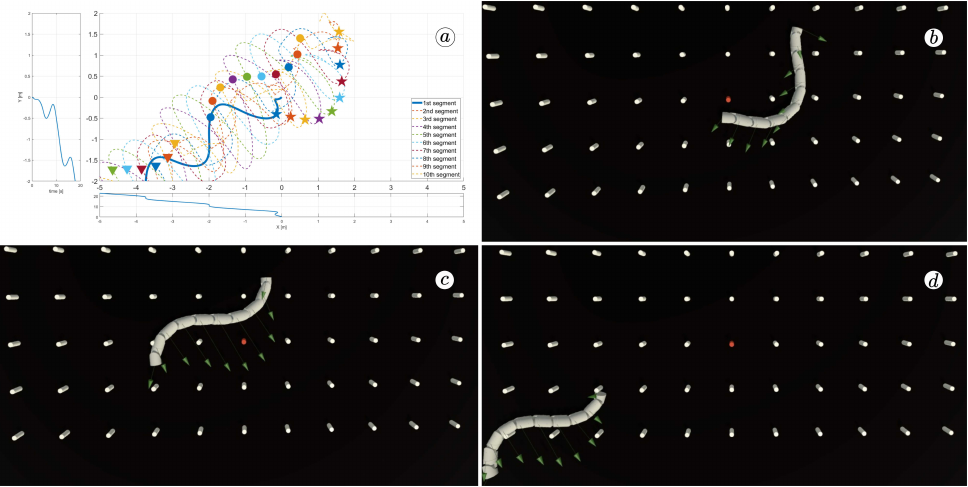
Figure 34. Trajectories of robot segments for φ i ,ref = 50 ◦ sin ( 50 ◦ t + ( i − 1 ) 30 ◦ ) ( a ) and robot configu- rations for t = 5 ( s ) ( b ), t = 10 ( s ) ( c ), and t = 24 ( s ) ( d ).